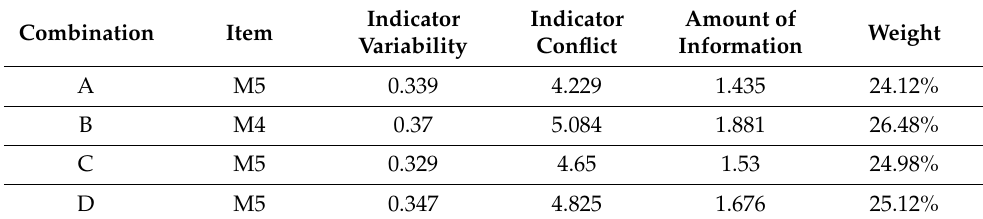
Table 8. Results of the maximum specific gravity for each combination of CRITIC weights.